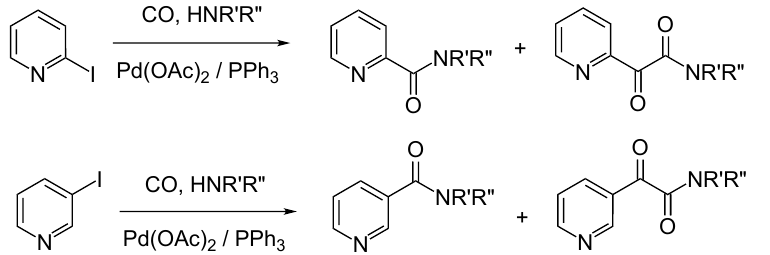
Figure 8. Pd-catalyzed aminocarbonylation of 2-iodopyridine and 3-iodopyridine with primary and secondary